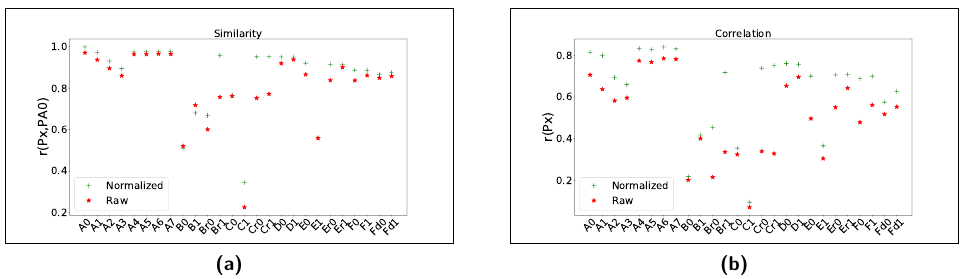
Figure 10: Similarity with the profile of device A0 (a) and strength of the leak (b) for profiles built on different devices during several acquisition campaigns over a a period of several hours. Apart from the few cases when the quality of a profile is low (due to the variability of the real environment), similarity (a) and correlation (b) are significantly high. The confidence is − log 10( p ) > 10 and r 10 even for the worse cases. The suffix r indicates z > a second acquisition campaign for the cases that had problems. The suffix d indicates the DAPLink debugger. The advantage of normalization over raw traces in clearly visible.